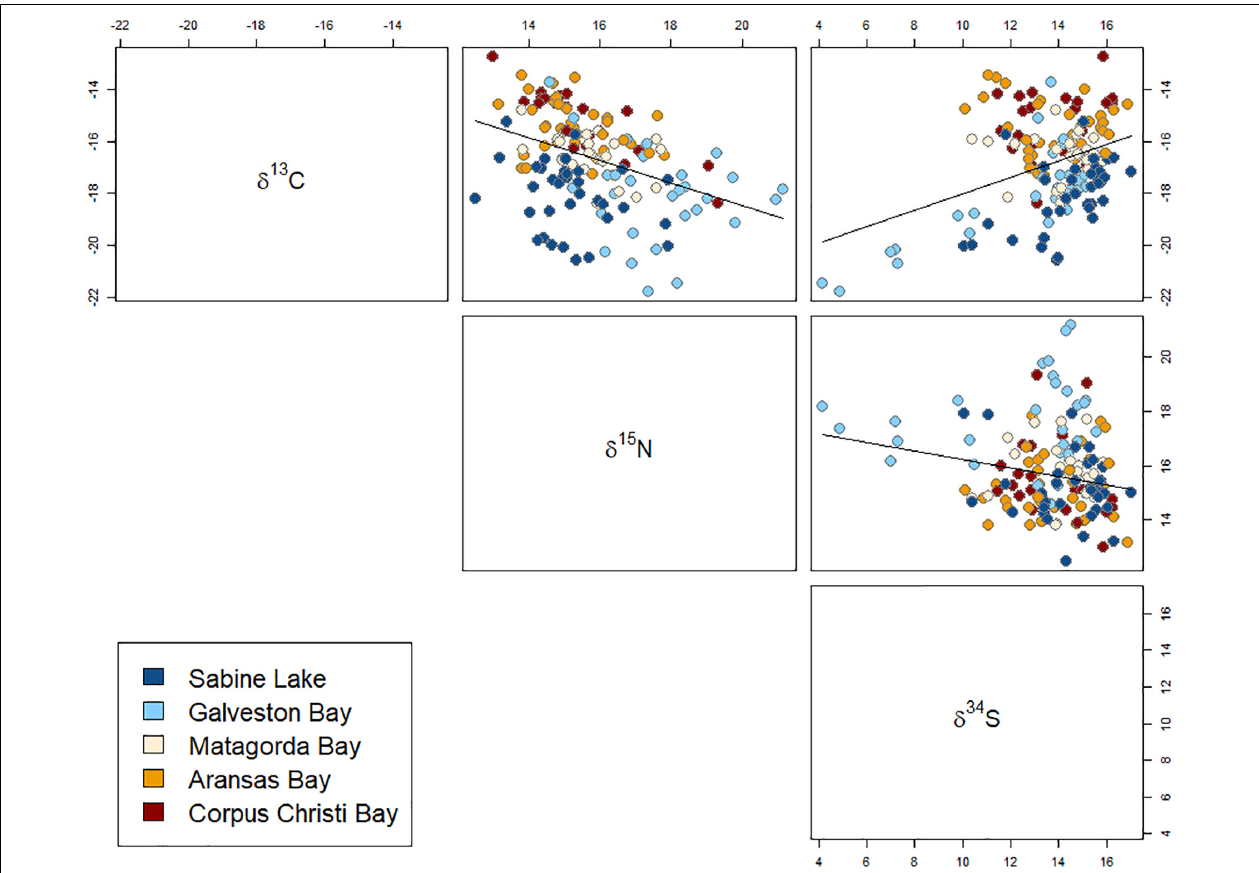
FIGURE 5 | Biplots of δ 34 S, δ 15 N, δ 13 C from muscle tissue of juvenile bull sharks collected from Texas estuaries (estuary indicated by filled circle color) and robust linear regression trendlines for estuaries in which isotope relationships were significant ( p <